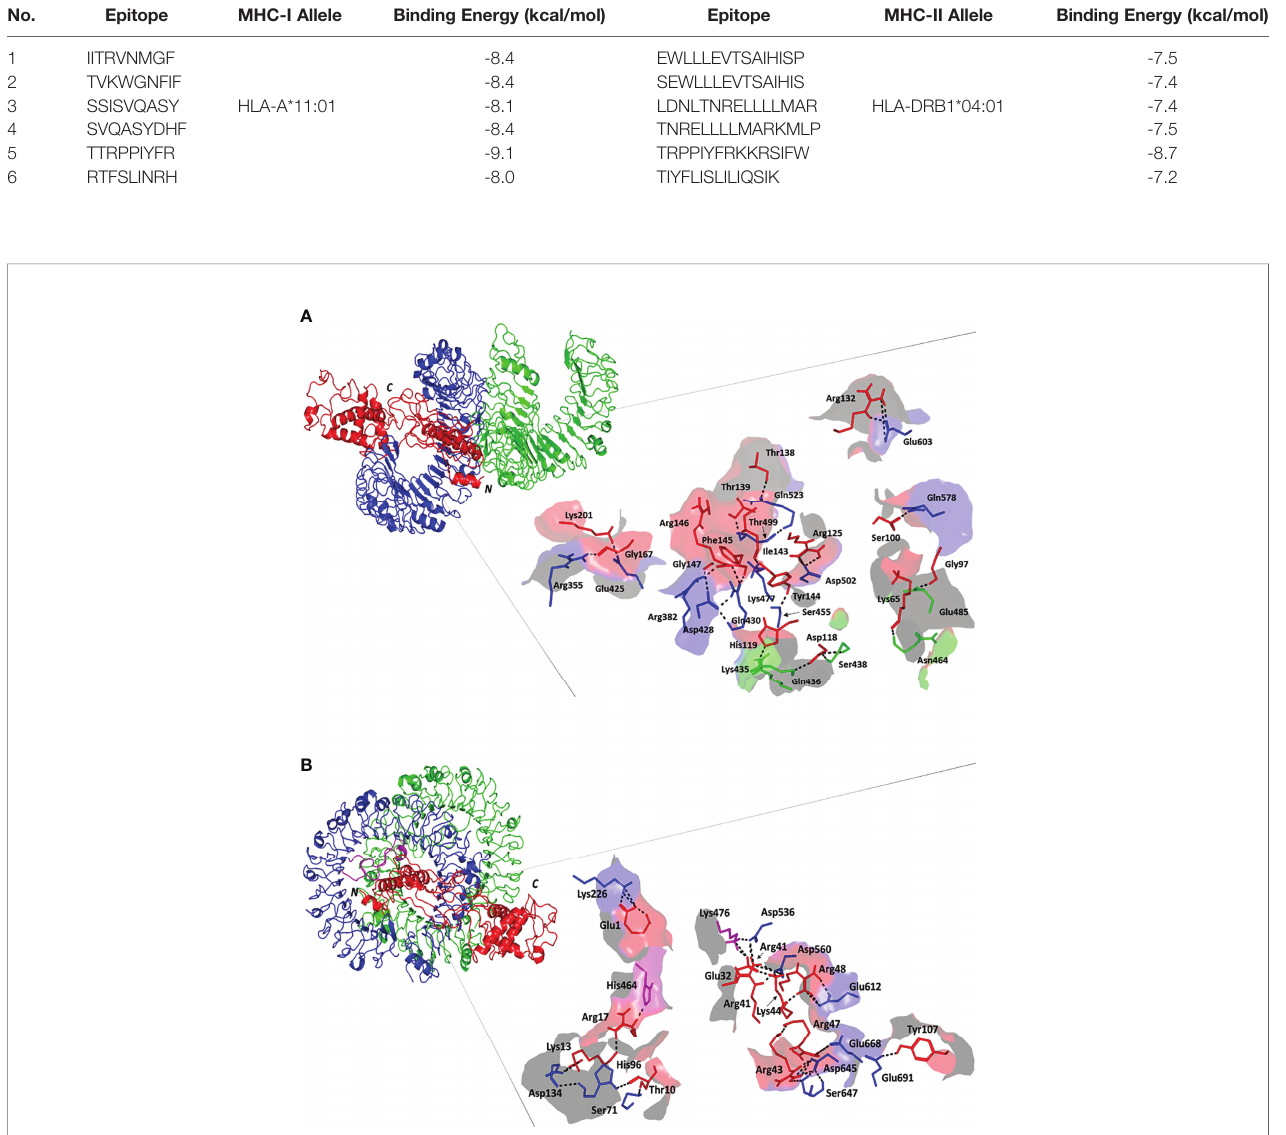
FIGURE 4 | Docked complex and interface binding interactions for the designed vaccine and the two investigated TLRs; (A) multiepitope vaccine/TLR-4 and (B) multiepitope vaccine/TLR-8 complexes. 3D cartoon representation of the docked vaccine (red) at the TLR binding site (green and blue for protomer A and B, respectively). The protruding loops into the TLR-8 binding site are colored magenta. The carboxy and amine terminals of the simulated epitopes are assigned with C and N -letters, respectively. Zoomed images illustrate the surface representation of multiepitope vaccine/TLR binding polar interactions showing the residue pairs as lines, colored depending on their location within the proteins, and numbered according to their respective residue sequence. The bonds of polar interactions are shown as black dashed